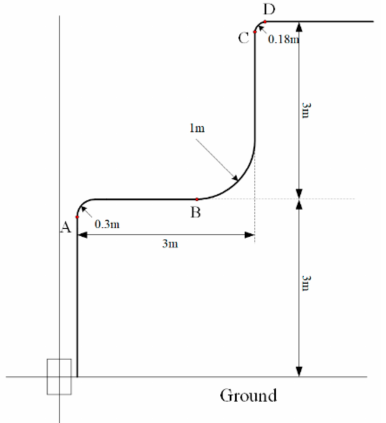
Figure 14. Reference